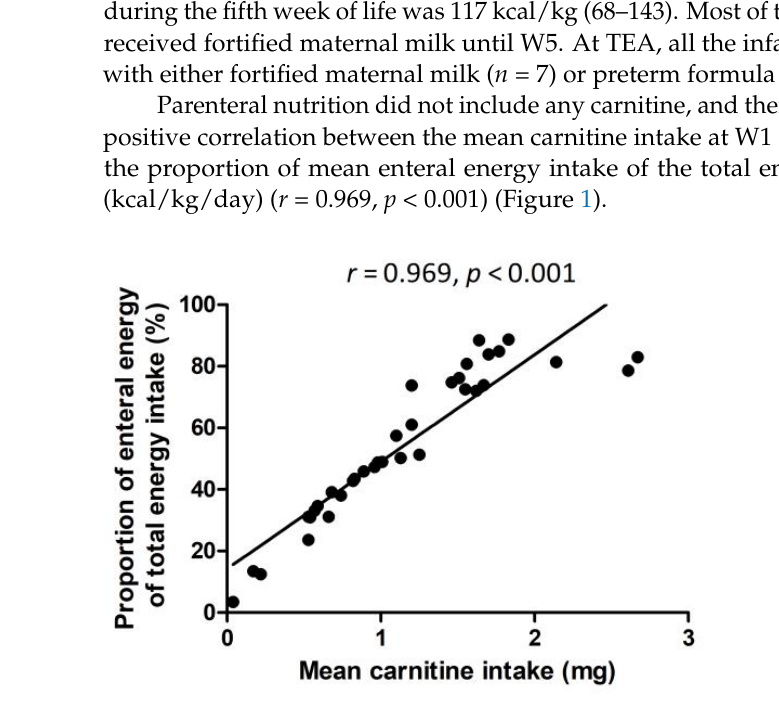
Figure 1. Spearman rank correlation between the mean daily carnitine intake (mg/kg) and proportion of mean enteral energy of the total daily energy (%) at weeks 1 and 5.